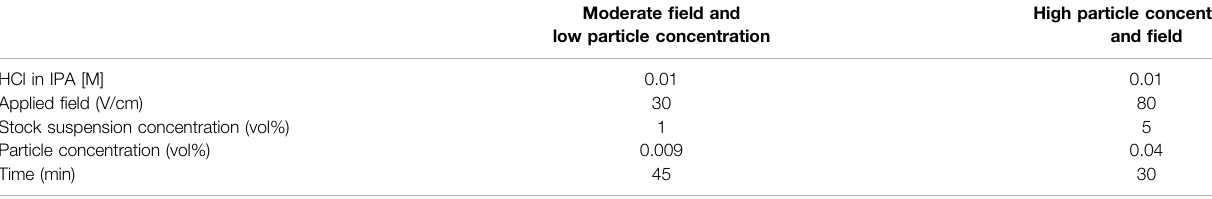
TABLE 1 | Experimental conditions for EPD.